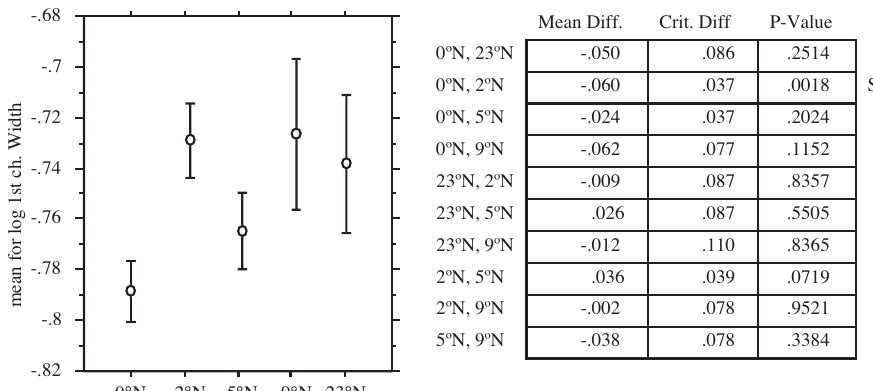
F IG . 5. – Comparison of polychaete size for the whole assemblage from each of the EqPac sites. The table gives the ANOVA analysis. Only 0ºN and 2º sites indicate significant differences in size.